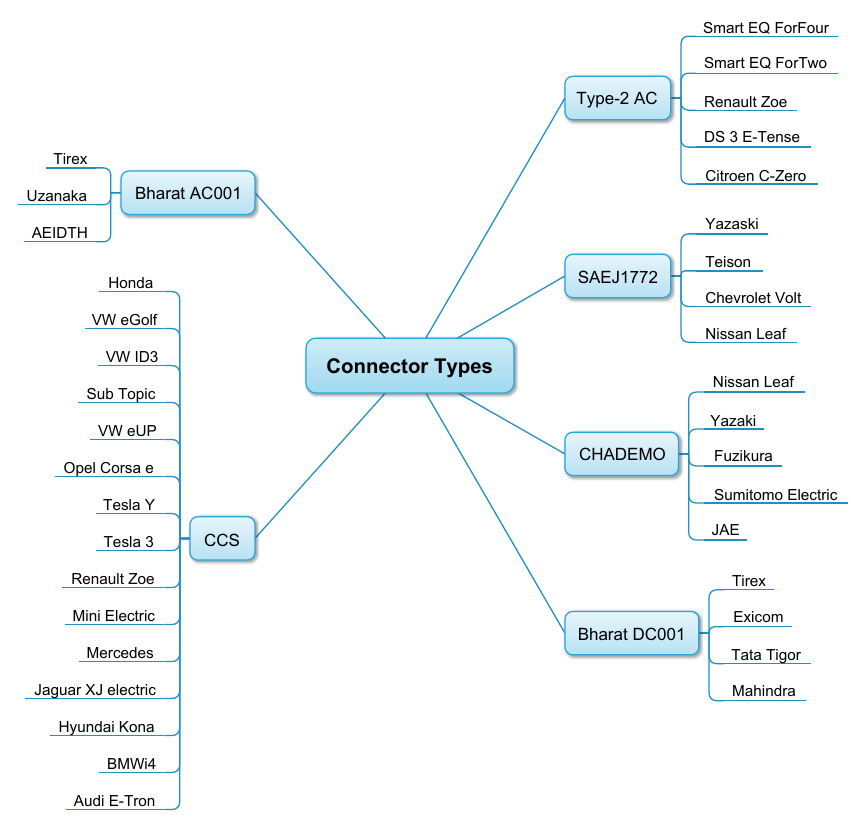
Figure 5. Taxonomy of charging connectors based on the manufacturers.